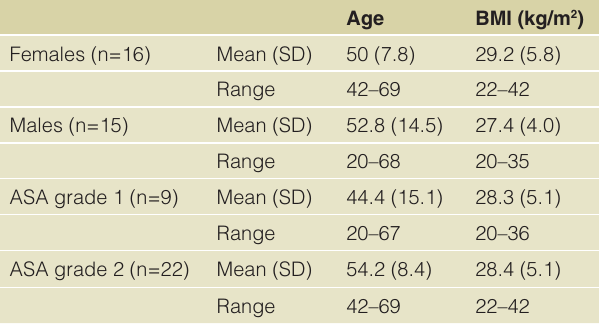
Table 1. Age and Body Mass Index by gender and ASA grade (n=31).